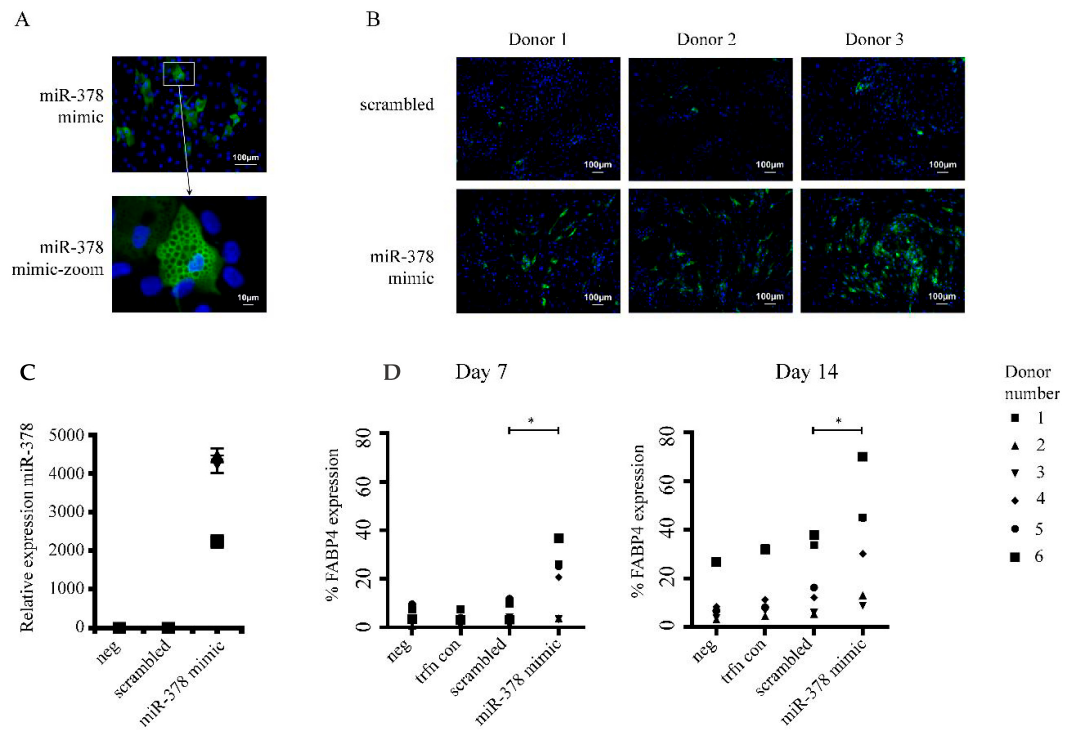
Figure 3. Over-expression of miR-378 increases the proportion of ASC that express FABP4 in an adipogenic assay. Late passage ASC were transfected with a miR-378 mimic and subjected to an in vitro adipogenic differentiation assay. Panel ( A ) shows a representative image of ASC subjected to the adipogenic differentiation assay taken at 20 X magnification. A single lipid-droplet containing cell staining positive for FABP4 expression is shown below in a cropped and enlarged image (labelled ‘zoom’). FABP4 positive cells are stained green and nuclei are stain blue. Panel ( B ) shows representative images from the adipogenic differentiation assay taken at day seven for quantification purposes for three donors (D1–D3) transfected with the miR-378 mimic or a scrambled control. The graph in ( C ) represents the relative expression of miR-378 in cells one week post transfection. Panel ( D ) shows the percentage of cells that stained positive for FABP4 expression after quantification at day 7 and 14 of the adipogeneic assay, n = 6. * denotes p value < 0.05.